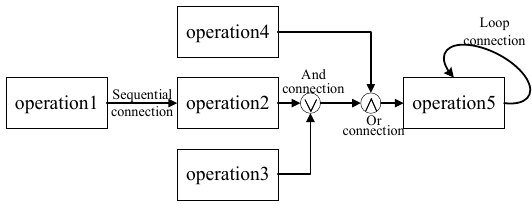
Figure 11. The decomposition of the execution tasks.